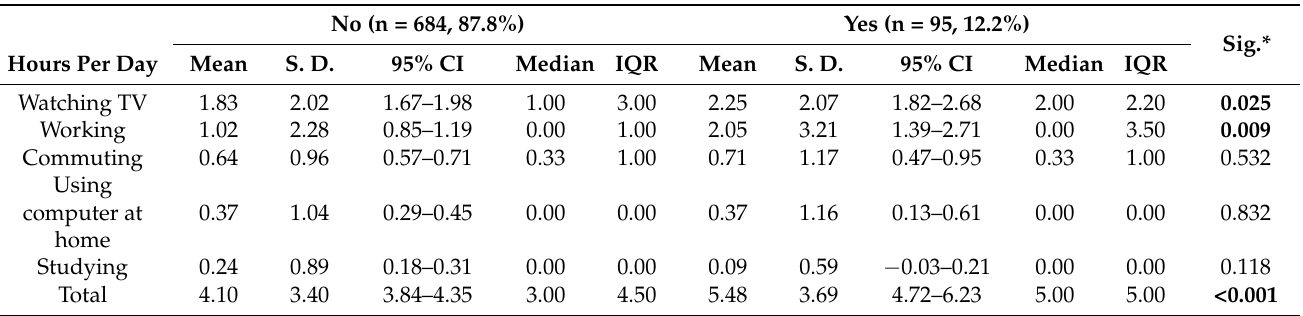
Table 3. Sedentary behavior according to counseling received from healthcare professionals in adults